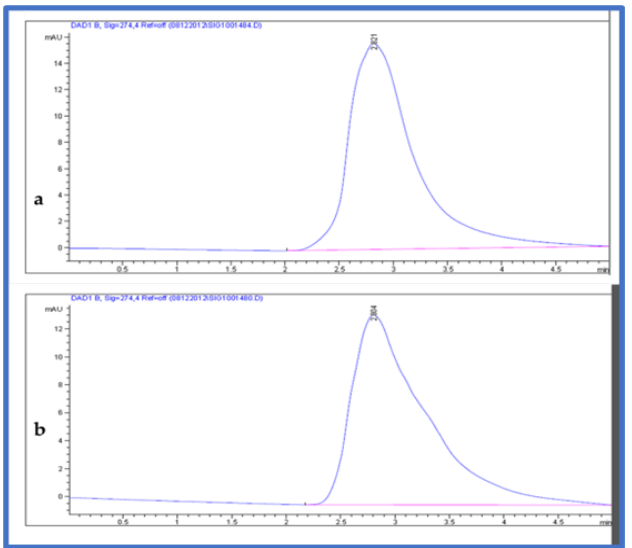
Figure 3. HPLC chromatogram ( a ) fructose standard and ( b ) fructose from fruit extracts.